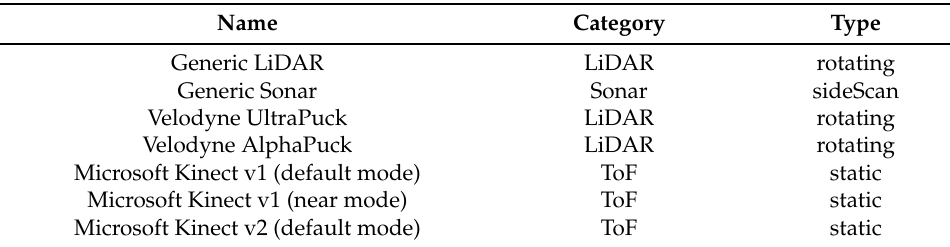
Table 1. List of predefined sensors in BLAINDER saved in the presets YAML-file.